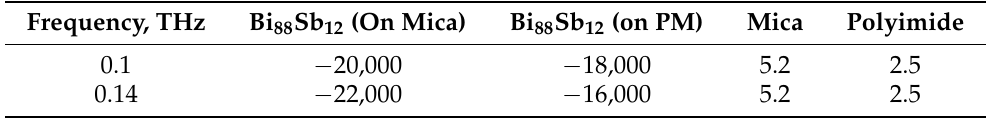
Table 1. Relative permittivity, real part.